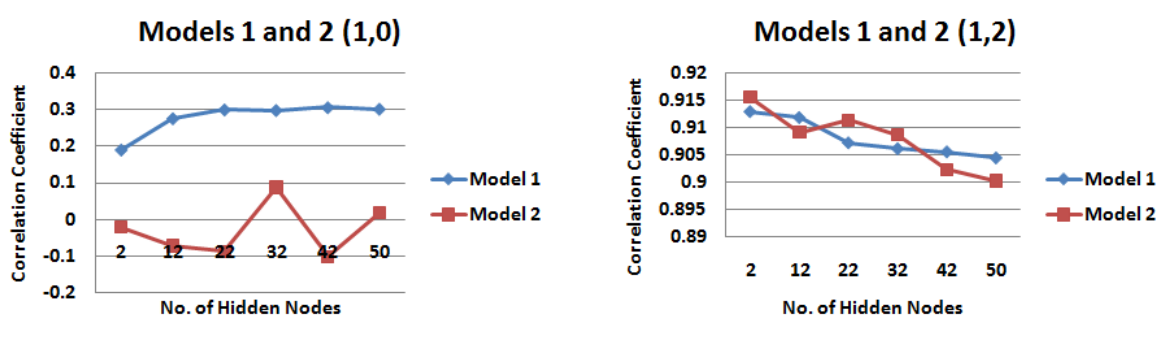
Figure 9. Correlation coefficients for input models 1 and 2 for 1 day rainfall information and 0 and 2 days water level information for strip 4 of the catchment— ( a ) Models 1 and 2 (1,0) ( b ) Models 1 and 2 (1,2) .